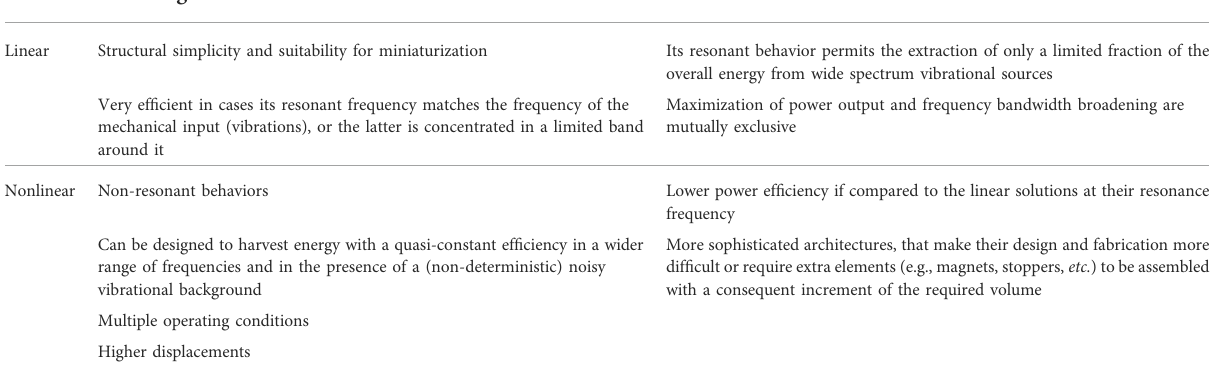
TABLE 1 Comparison of linear and non-linear